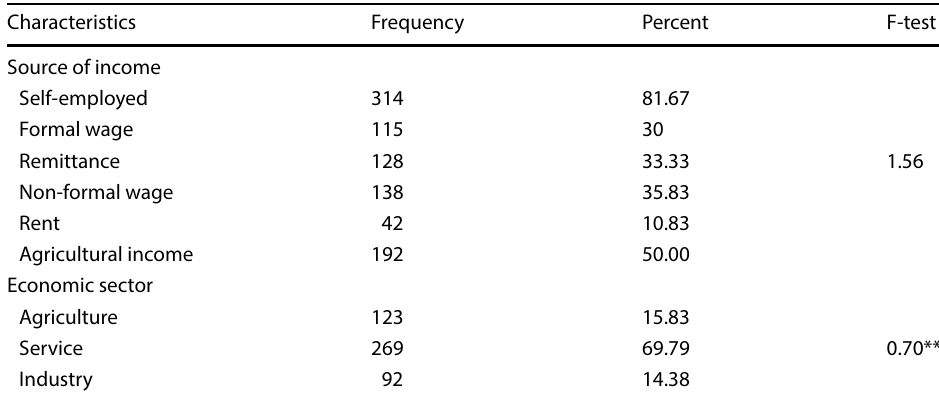
Table 3 Economic sector and source of income